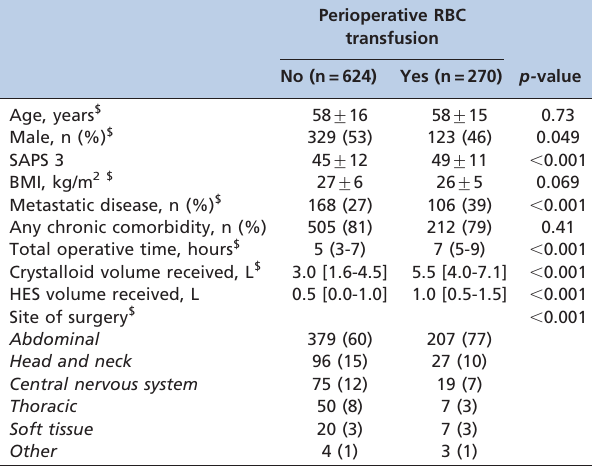
Table 2 - Univariate analysis of factors related to red blood cell transfusion.